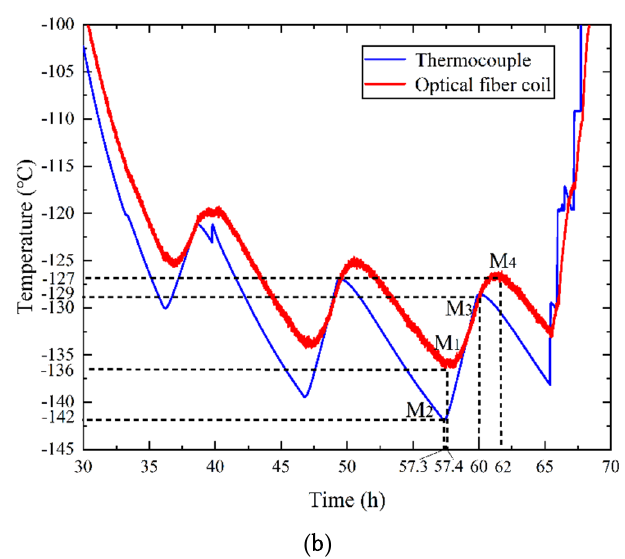
Figure 7. ( a ) The temperatures measured by the optical fiber sensor and thermocouple; ( b ) enlargement of the temperature curve below −100 °C.